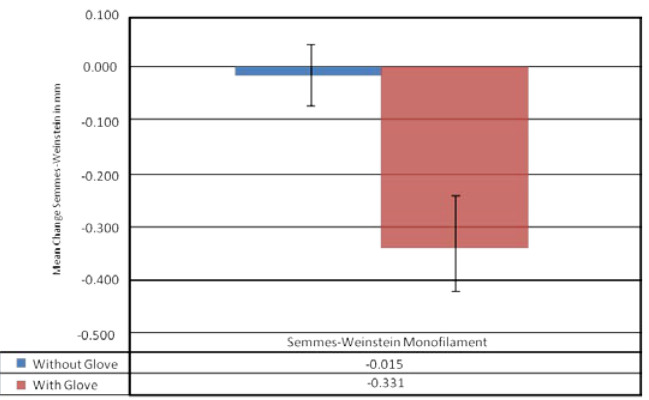
Fig. 6. Graphical depiction of Semmes-Weinstein results by condition.